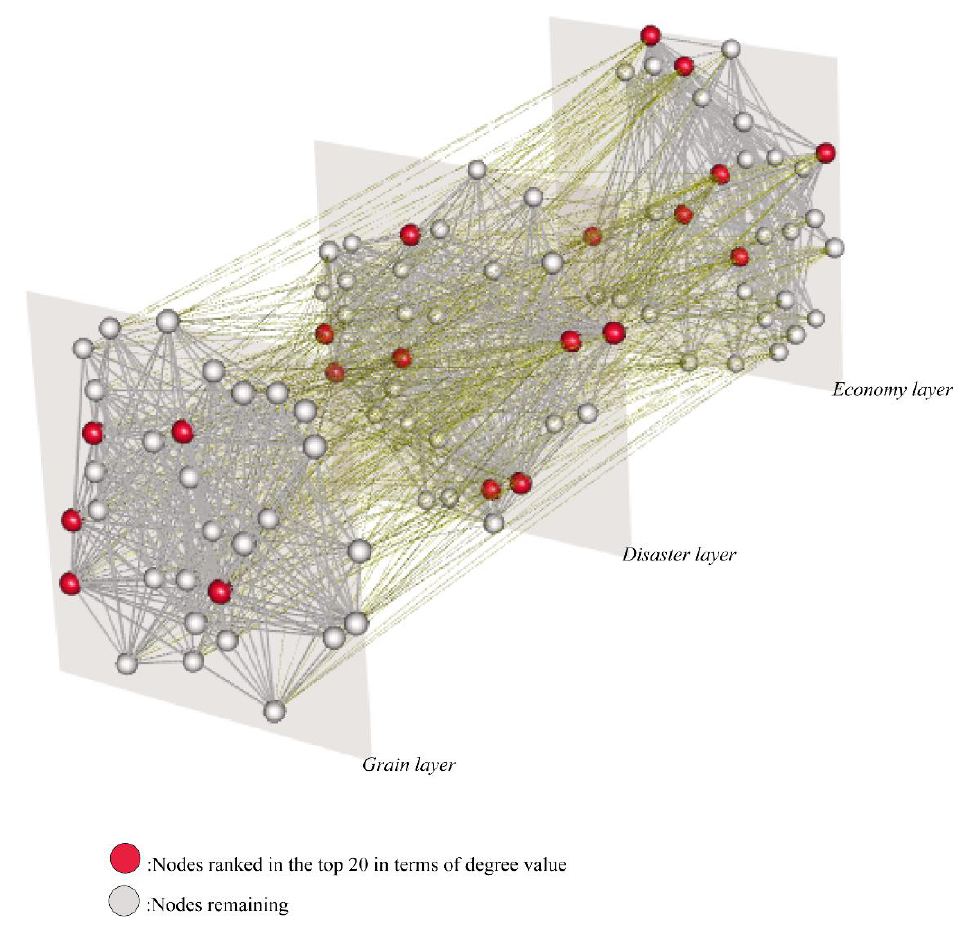
Figure 4. Spatial distribution of degree in grain–disaster–economy multilayer network.